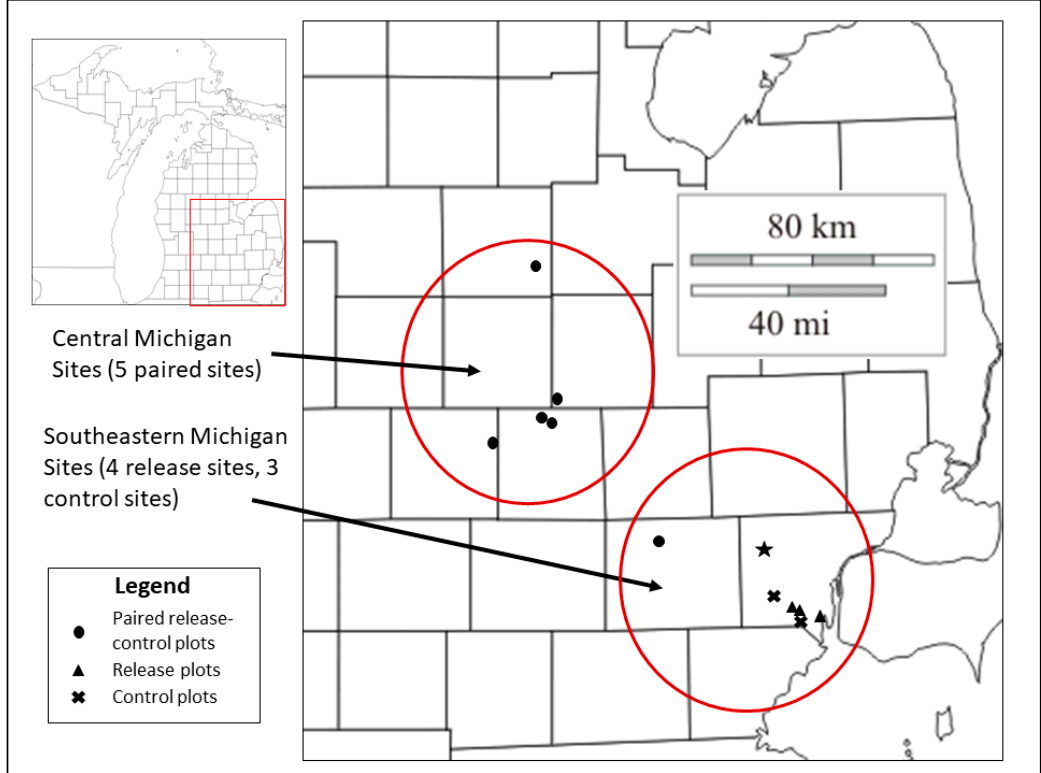
Figure 1. Location of study sites in two regions of southern Michigan where ash health data collection occurred in 2012 and 2015. Central Michigan sites include five paired release and control plots with parasitoid releases from 2007 to 2010; southeastern Michigan sites include four release and three control plots with parasitoid releases in 2011 (Table 1, Appendices A and B). The star indicates the approximate location of the EAB introduction point in Wayne County, Michigan [44].